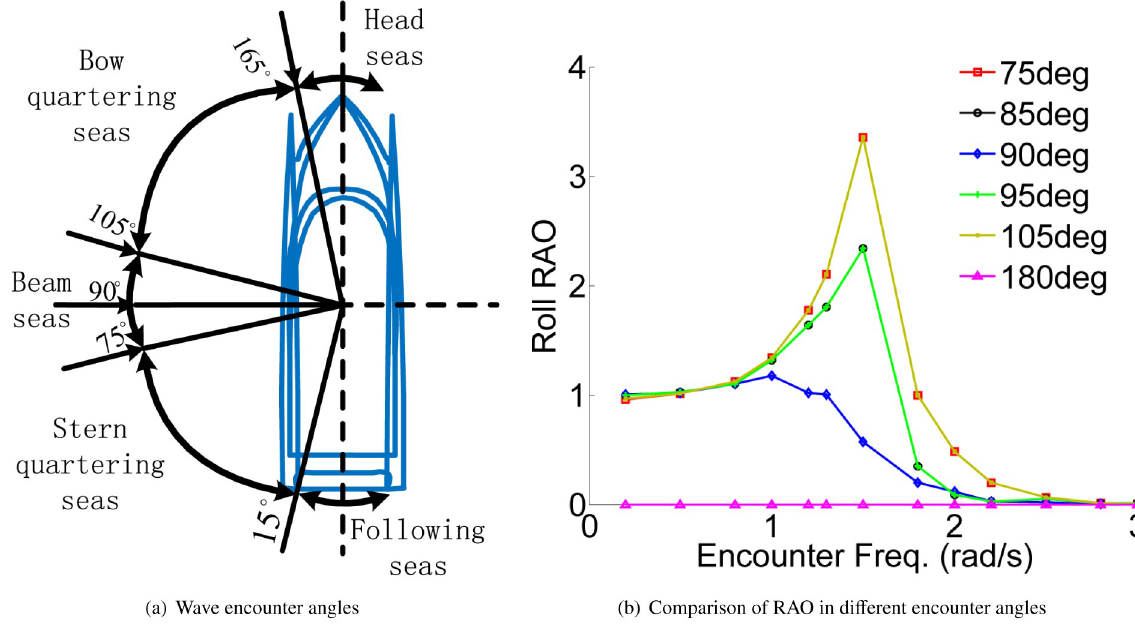
Fig 5. Encounter angles and roll RAO. (a) Wave encounter angles. (b) Comparison of RAO in different encounter